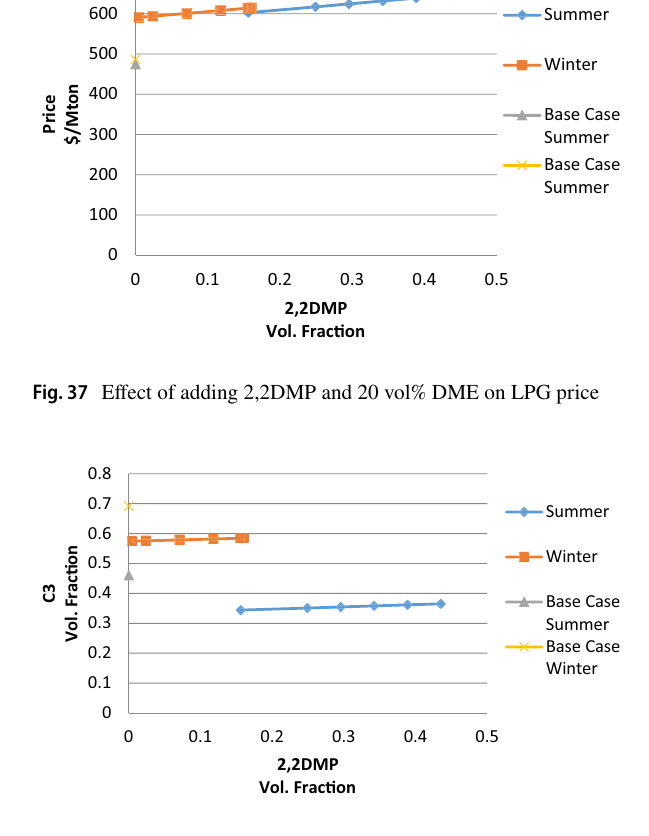
Fig. 38 Effect of adding 2,2DMP and 20 vol% DME on LPG propane content